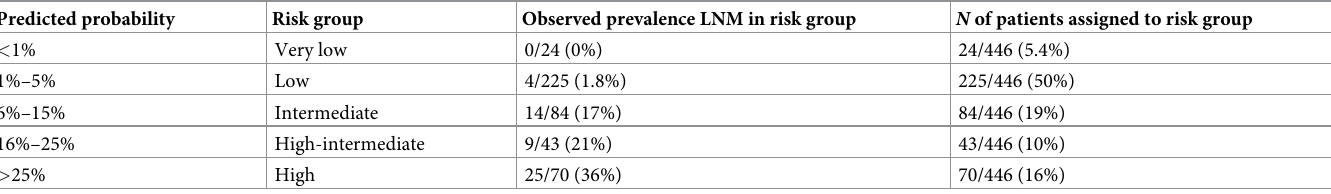
Table 3. Risk groups assigned based on predicted probabilities by the ENDORISK BN. Predicted probability Risk group Observed prevalence LNM in risk group N of patients assigned to risk